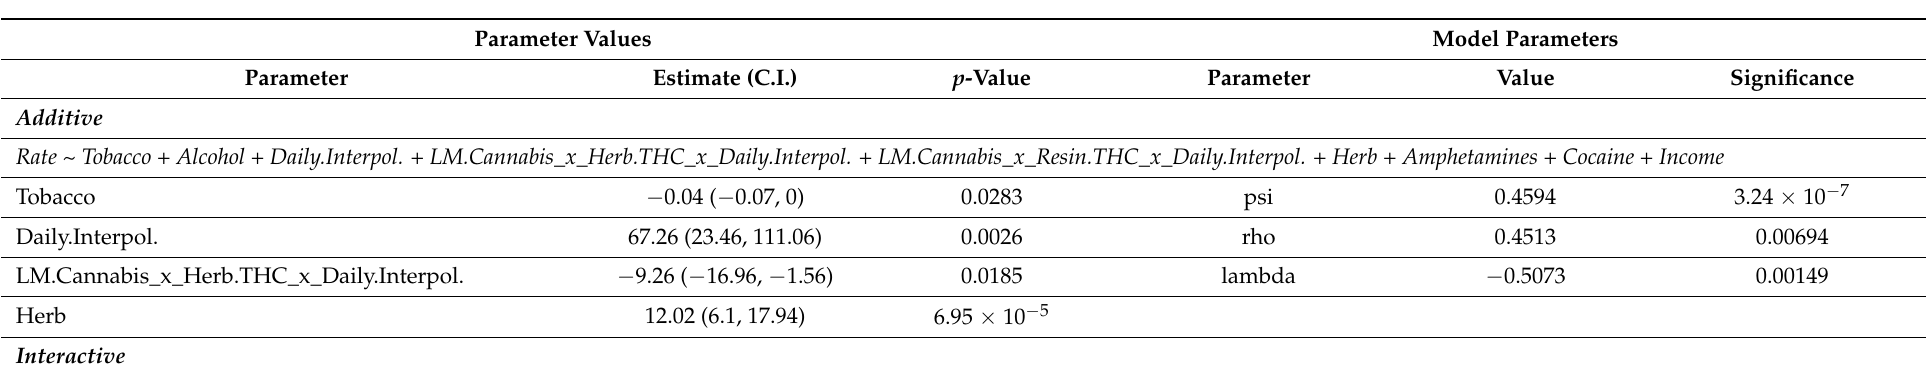
Table 5. Geotemporospatial Regressions for Hydronephrosis Congenital